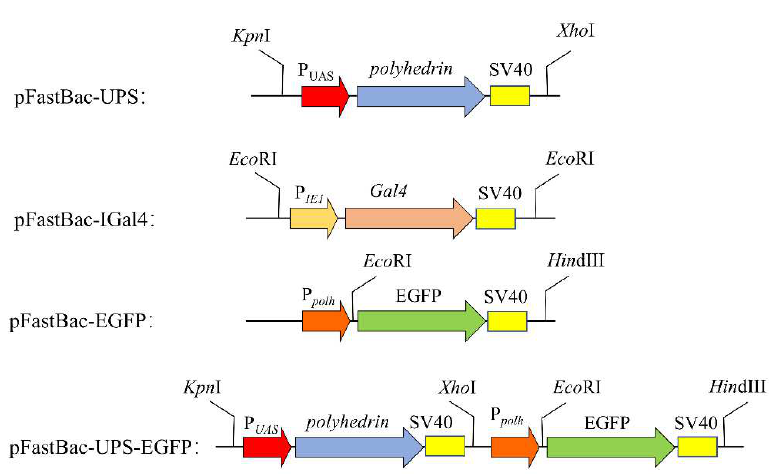
Figure 1. Construction strategies for recombinant Bacmids: pFastBac-UPS, pFastBac-IGal4, pFastBac- EGFP and pFastBac-UPS-EGFP.